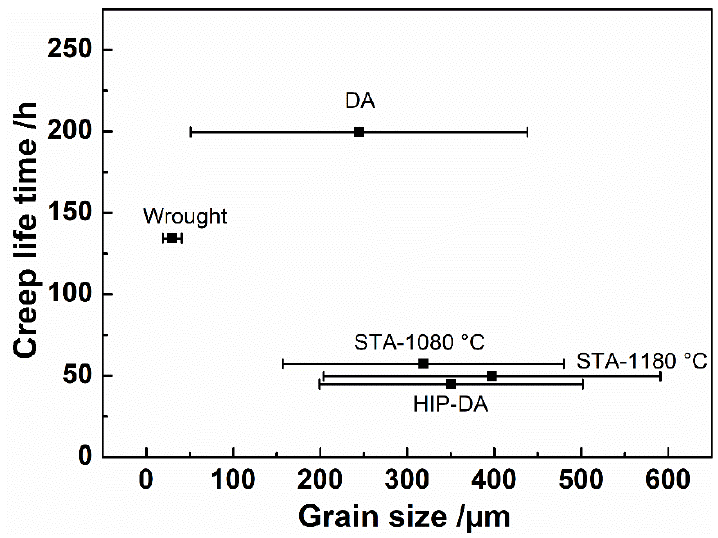
Figure 8. The creep lifetime dependence of the grain size measured for all investigated cases.